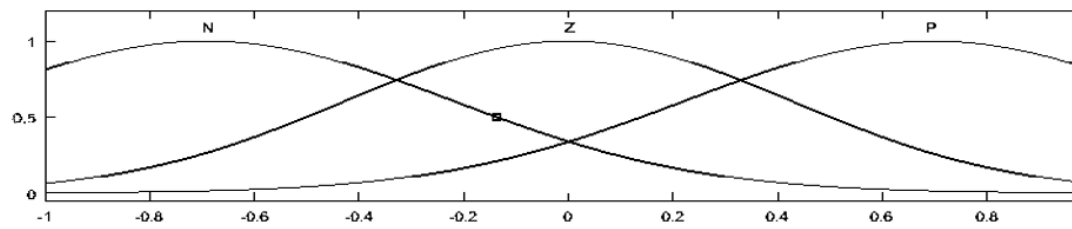
Figure 13. ∆ V de and ∆ V qe - Input membership function of change in error.